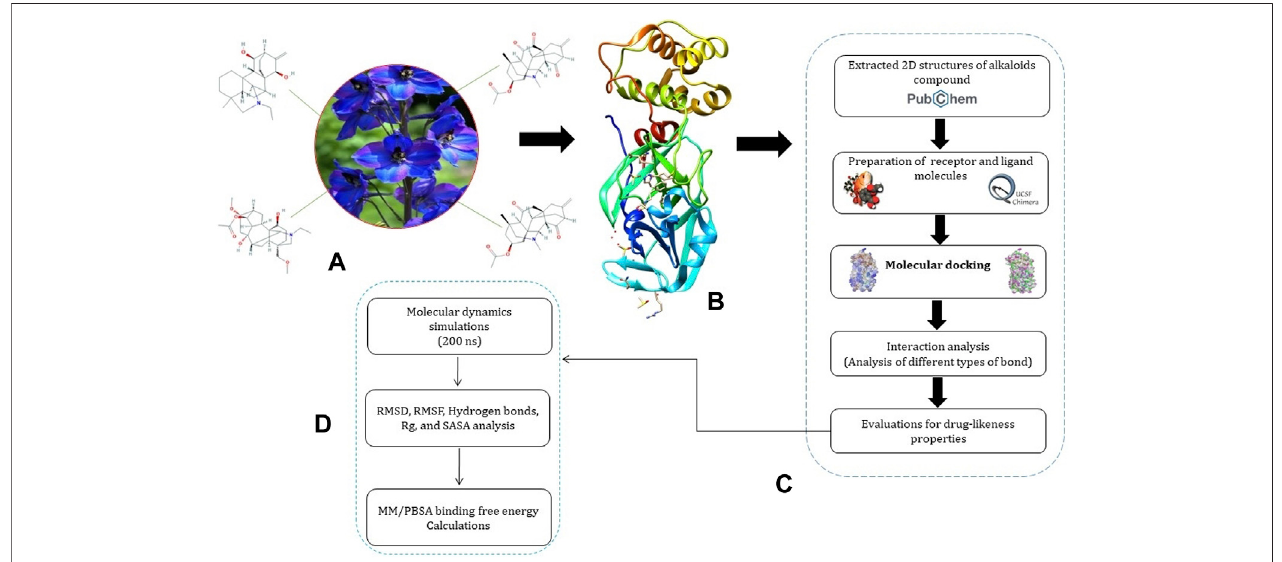
FIGURE1| Representationofpipeline. (A) 2DstructuresofJadwar-derivednaturalalkaloids(condelphine,denudatine,panicutine,andvilmorrianone)utilizedinthe present study; (B) 3D structure of M pro (PDB ID: 5R7Y) of COVID-19 obtained from the RCSB-PDB; (C) steps involved in the preparation of receptor and ligand molecules followed by docking; and (D) fl ow of steps utilized for performing molecular dynamics simulations and binding free energy calculations on 200